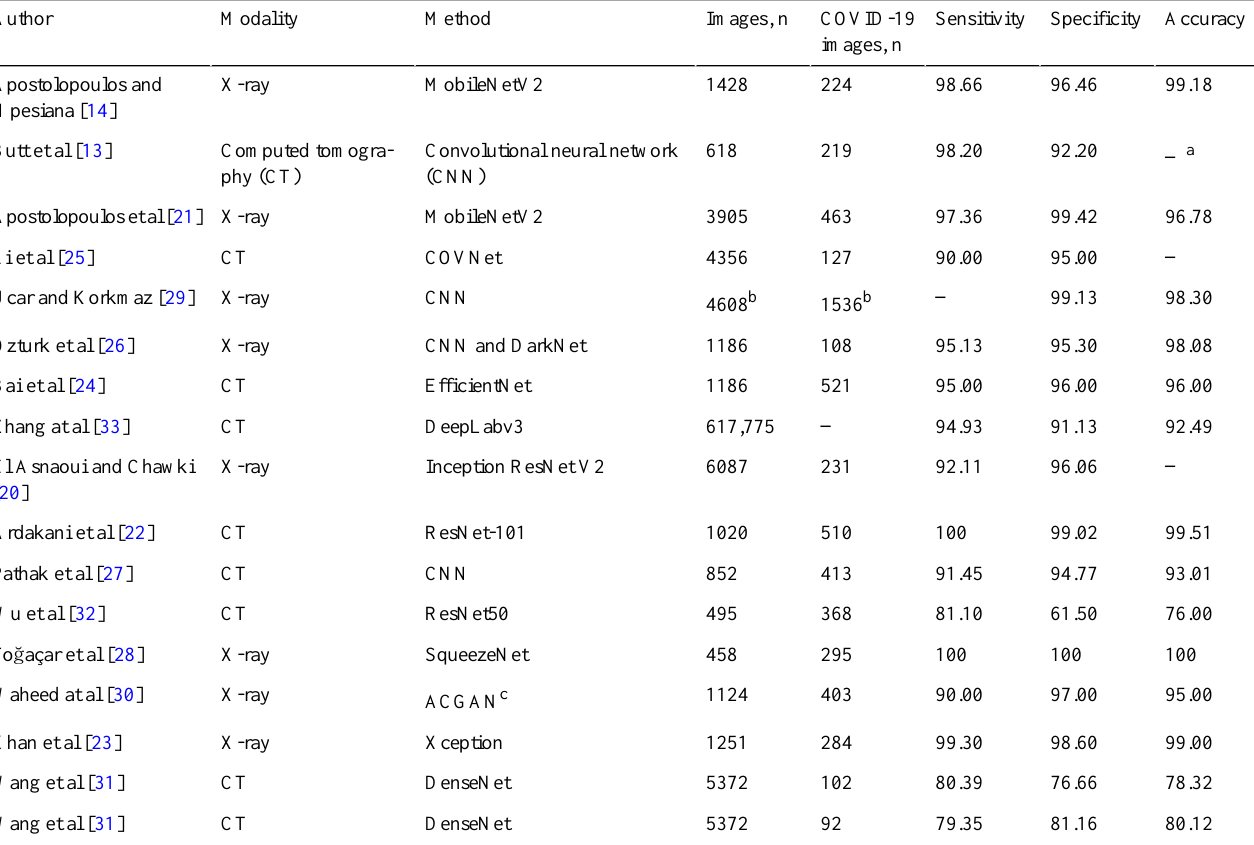
Table 1. Characteristics of the studies included in the meta-analysis.